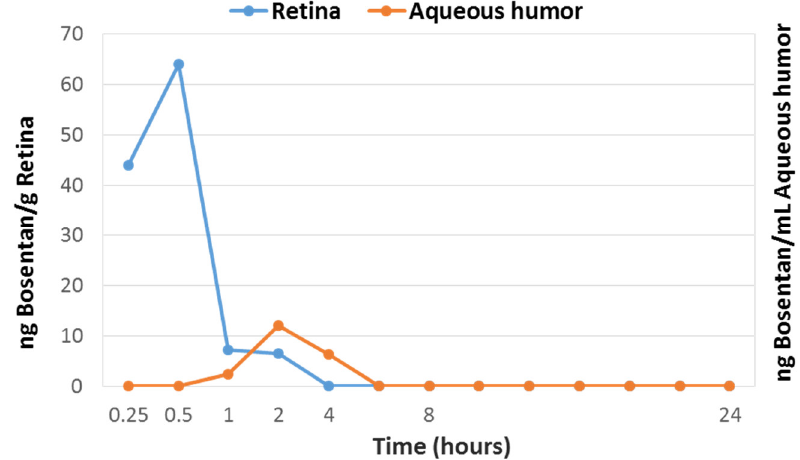
Figure 7. Bosentan content in retina (blue line, ng/g) and aqueous humor (orange line, ng/mL) of rabbits treated with one instillation of bosentan (50 µL, 0.5%).